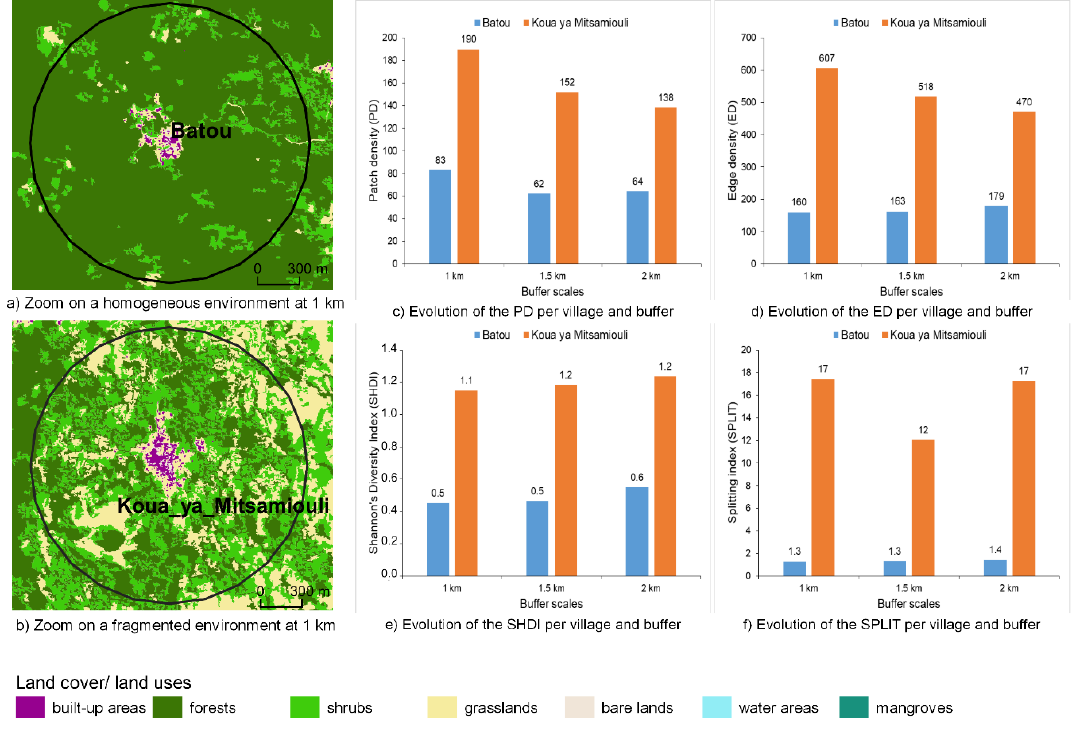
Figure 6. Comparison of landscape indices between a homogeneous and a fragmented environment.